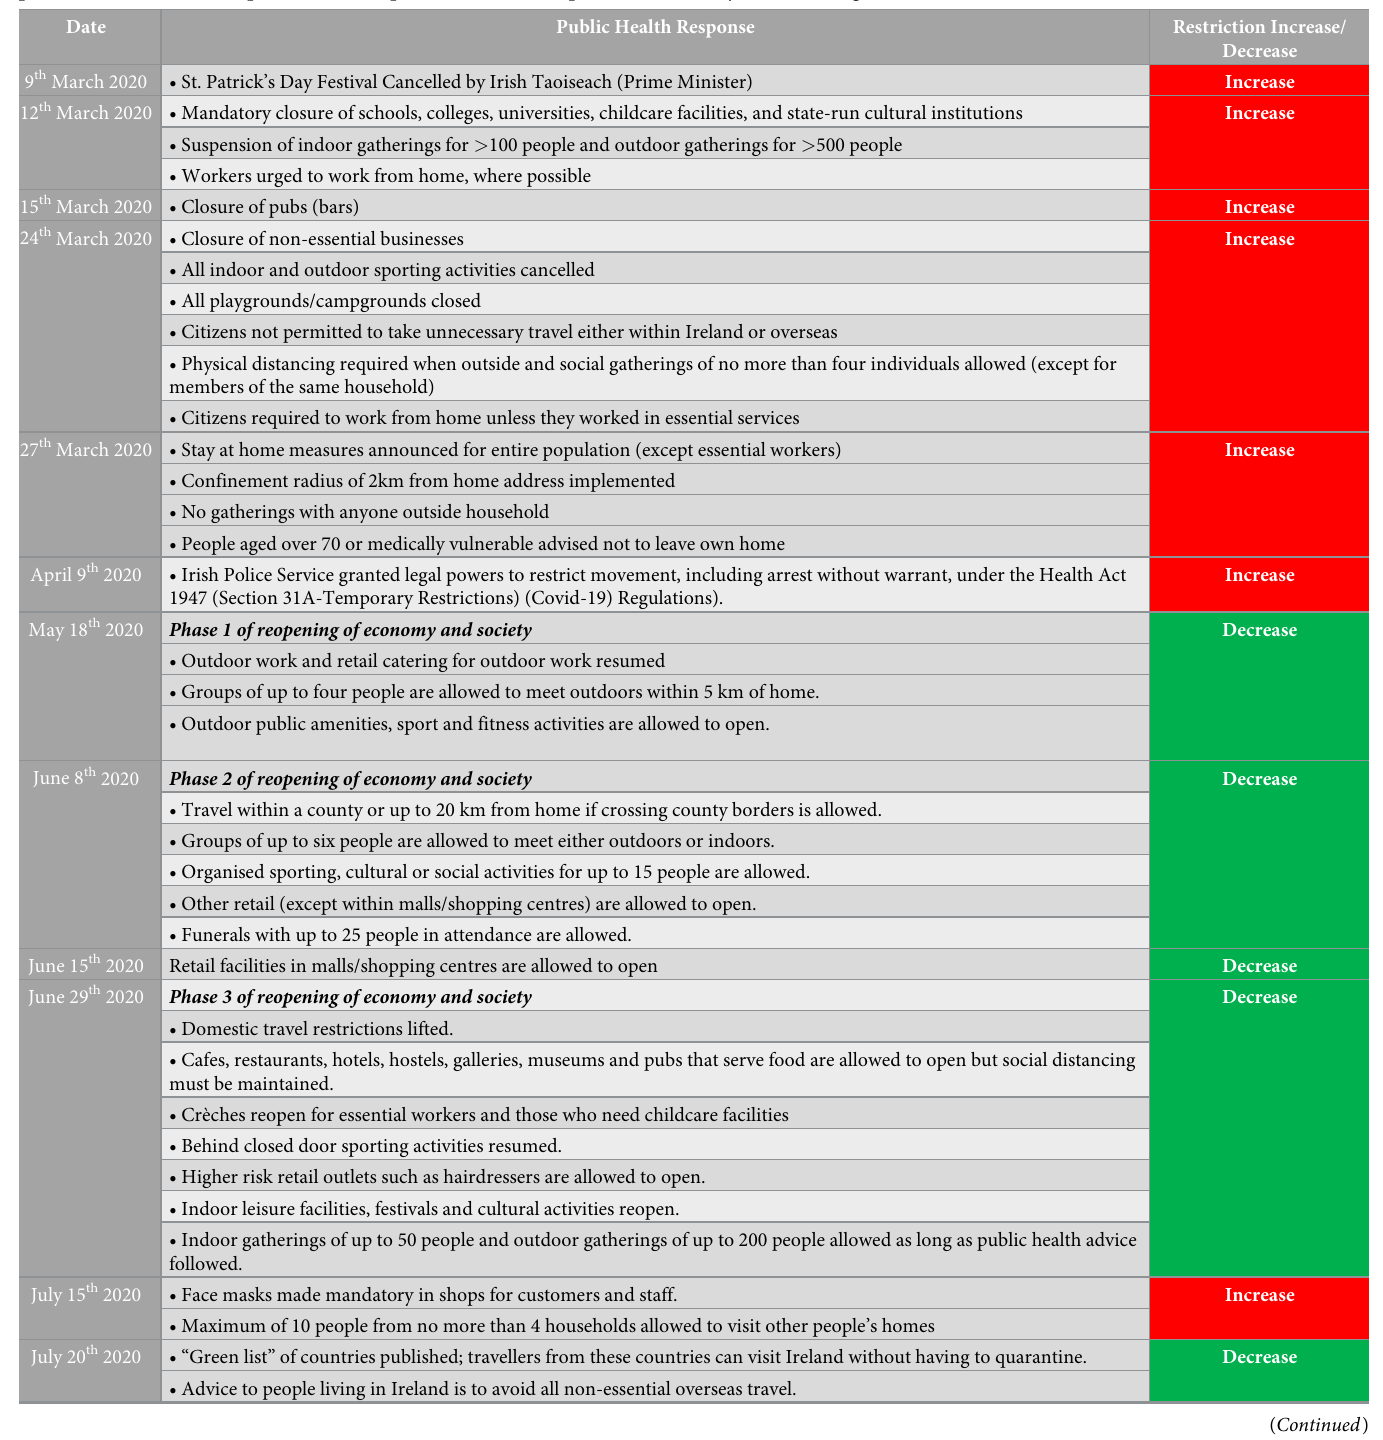
Table 1. Chronological summary of public health responses and non-pharmaceutical interventions (NPIs) implemented in the Republic of Ireland in response to COVID-19 Pandemic, March–October 2020 (Note: Due to ongoing national and regional/local changes to public health responses over the course of the study period, Table 1 is not a comprehensive description of all NPIs, but provides a summary of the most significant nationwide